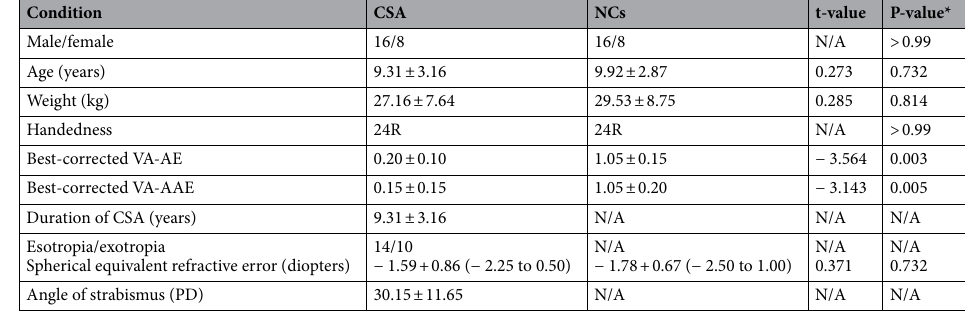
Table 1. The Conditions of participants included in the study. Notes: *P < 0.05 Independent t-tests comparing two groups. CSA children with strabismus and amblyopia, NCs normal controls, N/A not applicable, PD prism diopter, VA visual acuity, AE amblyopic eye, AAE another amblyopic